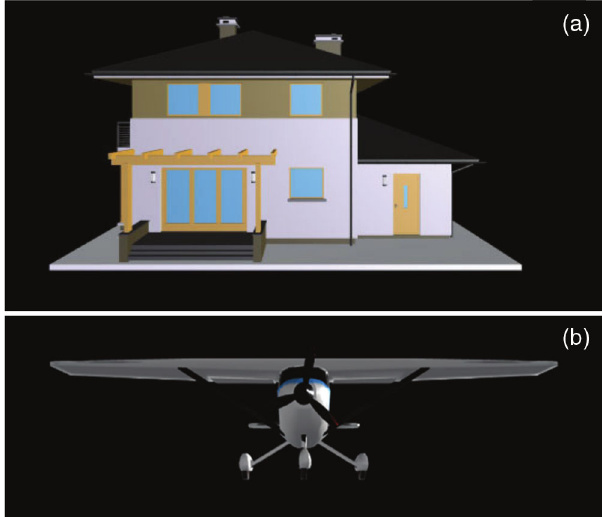
FIG. 1. Screen shots from two preliminary training scenes. Students were asked to rotate the house in (a) and count the panes of glass. They were then asked to view the rotation of the propeller on the plane in (b) and determine the direction of the angular momentum using the right-hand rule.